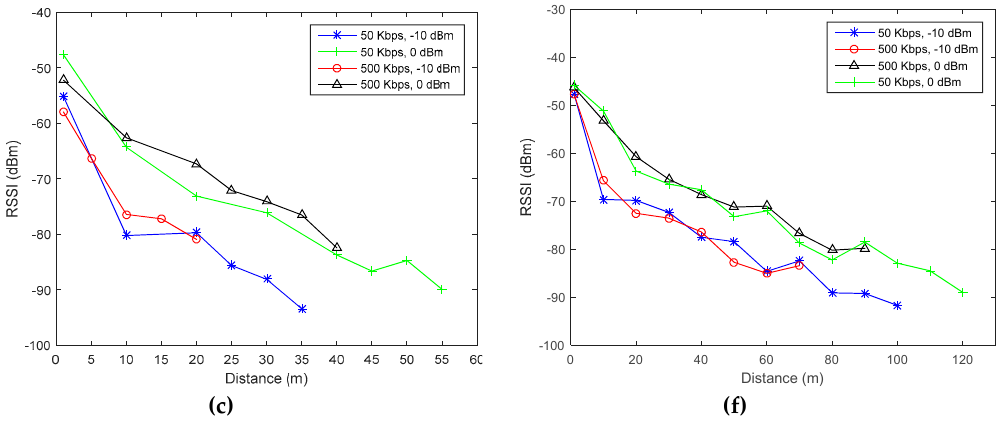
Figure 12. BER, PER, and RSSI field measurements in ( a – c ) the urban and ( d – f ) the suburban areas.